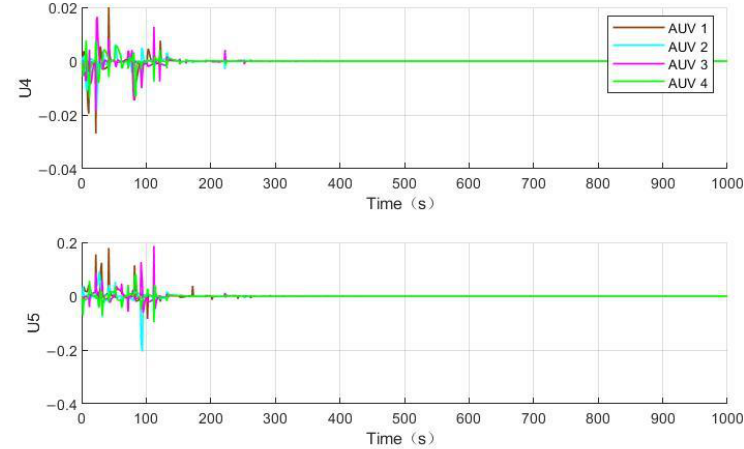
Figure 13. Control input of second-order integral model of followers.